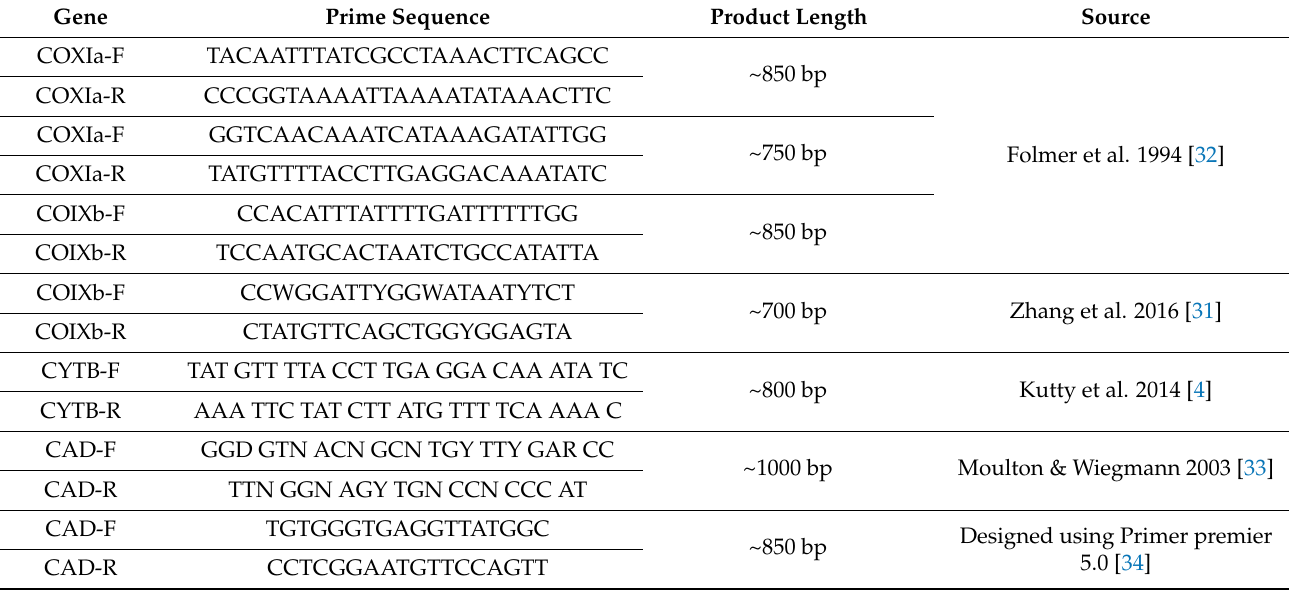
Table 1. Primers sequences used for PCR amplication and